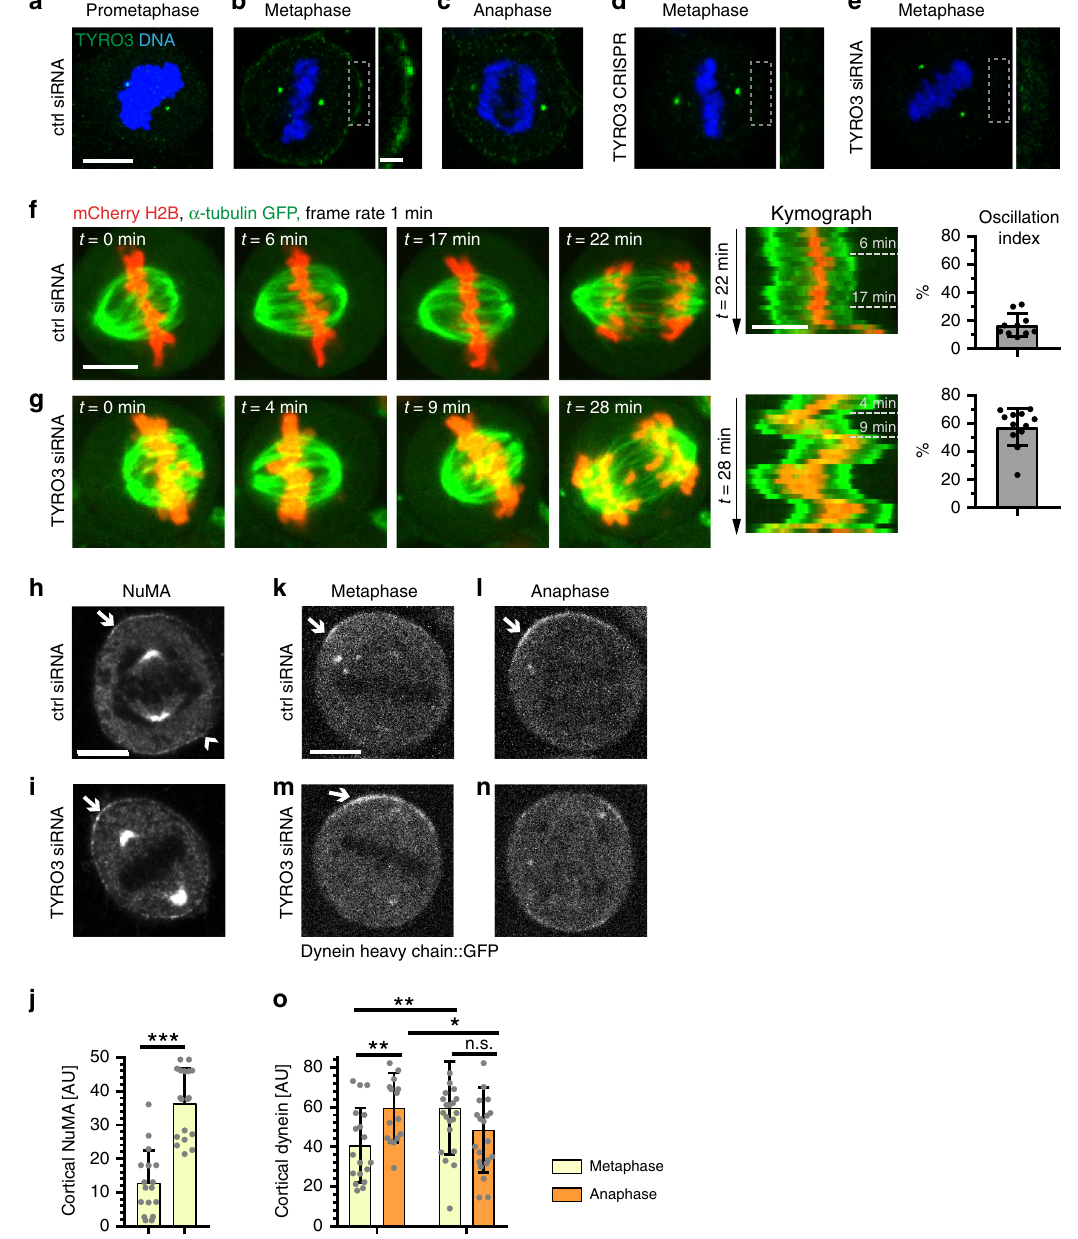
Fig. 4 Tyrosine receptor kinase 3 (TYRO3) limits metaphase cortical NuMA/dynein accumulation. a – e Immuno fl uorescence of HeLa cells treated with ctrl small interfering RNAs (siRNAs) ( a , prometaphase; b , metaphase; c , anaphase), TYRO3 CRISPR/Cas9 cells ( d , metaphase), as well as TYRO3 siRNA ( e , metaphase), all stained with TYRO3 antibodies (green). DNA in blue. Scale bar: 10 µ m. The insets of the cortical regions boxed in b , d , and e are magni fi ed on the right in each case. Scale bar: 2 µ m. The two dots on each side of the metaphase plate correspond to unspeci fi c centrosomal signal. f , g Stills (left) and corresponding kymographs (right, with position of stills indicated) from live imaging of HeLa expressing mCherry::H2B and GFP:: α - tubulin after ctrl, n = 10 cells ( f ) or TYRO3 siRNA, n = 11 cells ( g ), from three independent experiments each, with corresponding mean oscillation indices values ± SD. Scale bars: 10 µ m, *** p = 6 × 10 − 8 , comparing ctrl and TYRO3 siRNA oscillation indices using unpaired two-tailed Student ’ s t test with Welch ’ s correction. h , i Immuno fl uorescence analysis of metaphase HeLa cells treated with ctrl or TYRO3 siRNAs and stained with NuMA antibody. Arrows point to cortical signal. j Quanti fi cation of cortical signal corresponding to h and i . Shown are mean values (in arbitrary units, AU, ±SD) of background-corrected cortical intensities (Methods) from four independent experiments, in each case quantifying 3 – 5 cells per group, yielding a total of 17 cells for ctrl and 18 cells for TYRO3 siRNAs; *** p = 2 × 10 − 7 , Mann – Whitney U test. k – n Still images from live imaging of HeLa cells in either metaphase or anaphase, as indicated, carrying dynein heavy chain::GFP and treated with ctrl ( k , l ) or TYRO3 ( m , n ) siRNAs. o Quanti fi cation of cortical green fl uorescent protein (GFP) signal from n to q in metaphase and anaphase. Shown are mean values (±S.D.) of n = 18 cells for control metaphase and anaphase, n = 23 cells for TYRO3 metaphase, and n = 22 cells for TYRO3 anaphase from three independent experiments each. Statistical analyses were conducted with unpaired two-tailed Student ’ s t -test with Welch ’ s correction; ctrl meta vs. ana: ** p = 0.003, ctrl meta vs. TYRO3 meta: ** p = 0.0065, ctrl ana vs. TYRO3 ana: * p = 0.0446, TYRO3 meta vs. TYRO3 ana: p = 0.09. n.s. not signi fi